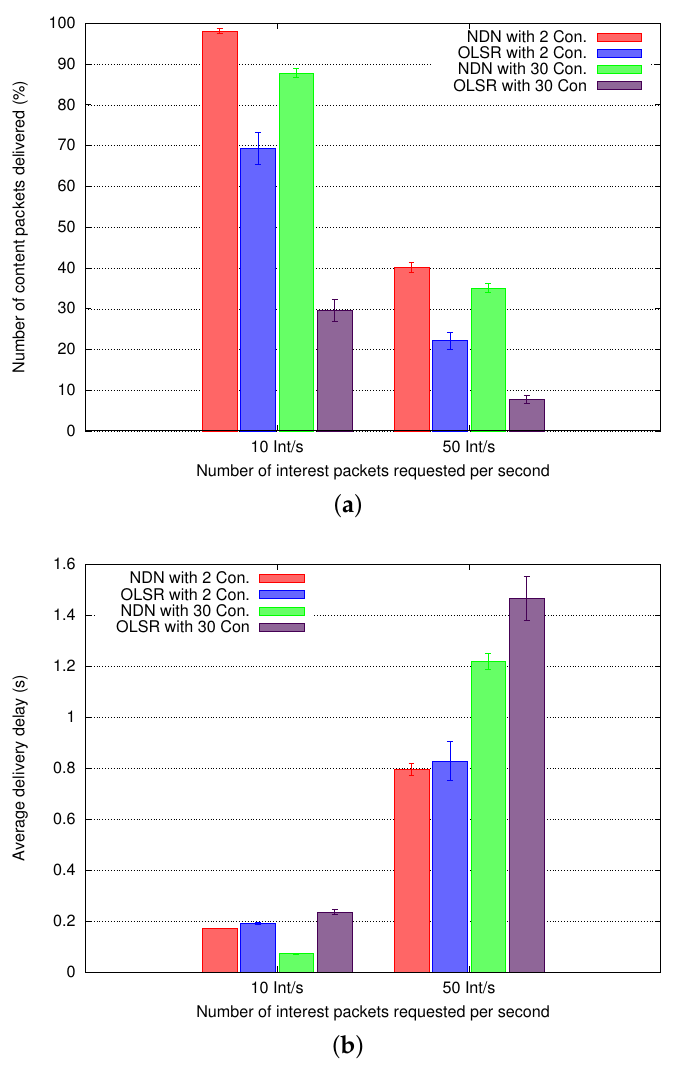
Figure 6. Default NDN vs. TCP/IP with OLSR: content delivery rate and average